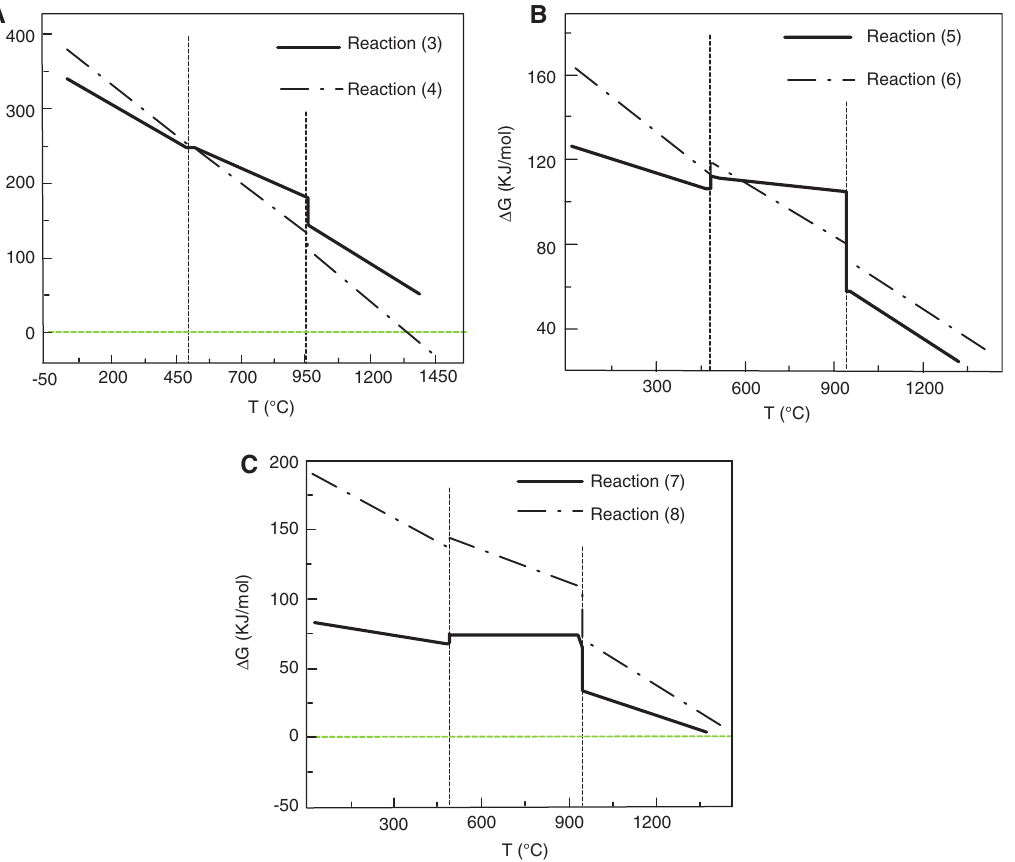
reaction and temperature: (A) Eqs. (3) and (4), (B) Eqs. (5) and (6), (C) Eqs. (7) and (8). 2